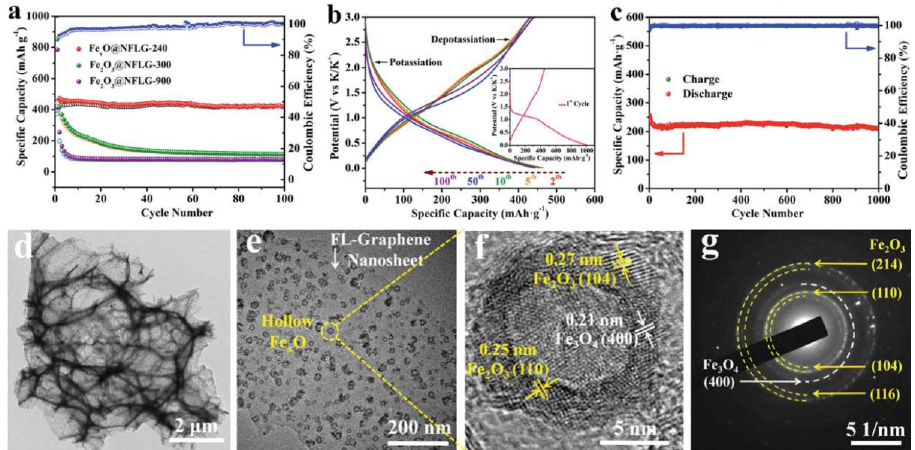
Figure 8. ( a ) Comparison of cycle performances and capacity retention for Fe x